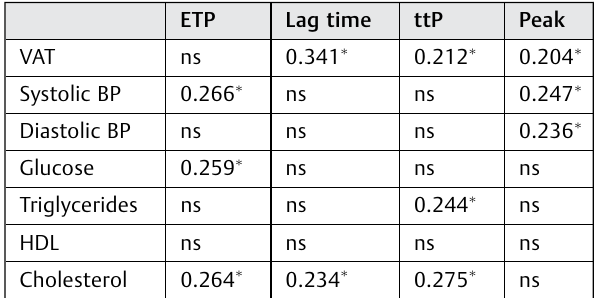
Table 5 Multiple regression models of anthropometric,